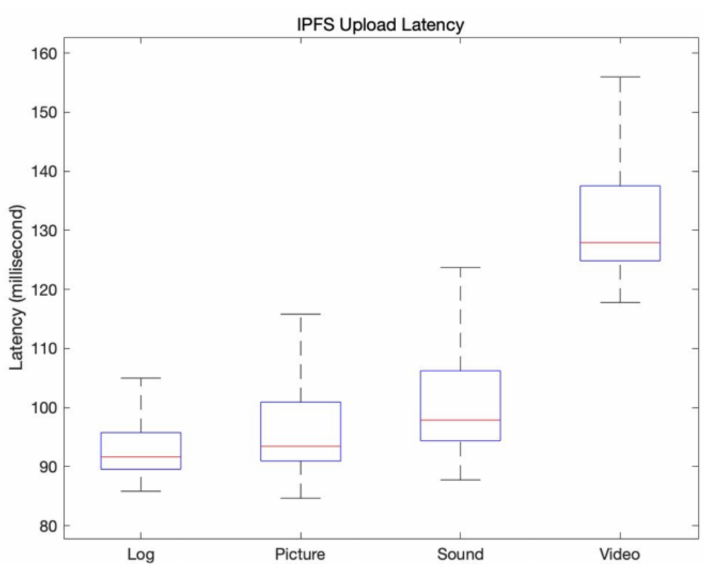
Figure 10. IPFS Upload